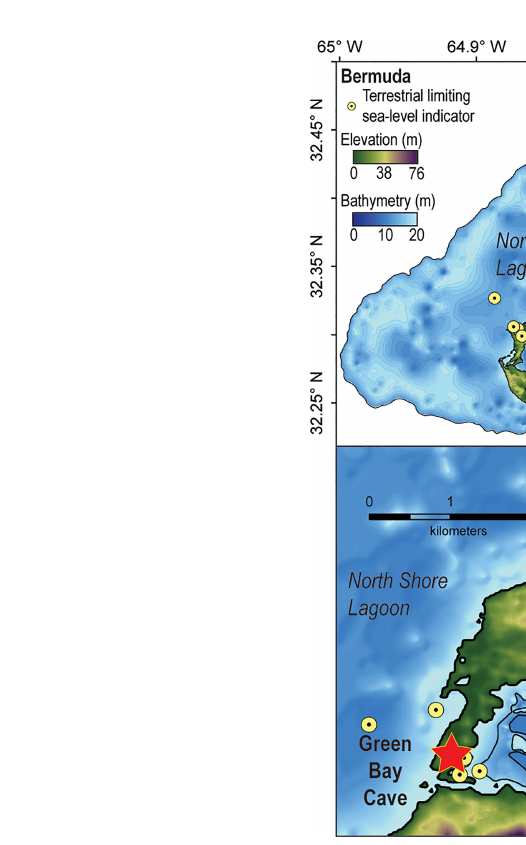
FIGURE 1 | Digital elevation model of Bermuda in the North Atlantic Ocean (https://data.noaa.gov/datasetsearch/) with detailed map of Harrington Sound (Vollbrecht, 1996) plotted in ArcGIS. Yellow markers identify the locations upper limiting (terrestrial or freshwater peat, Hijma et al., 2015) sea-level indicators compiled into a regional upper limiting database ( n =113, van Hengstum et al.,